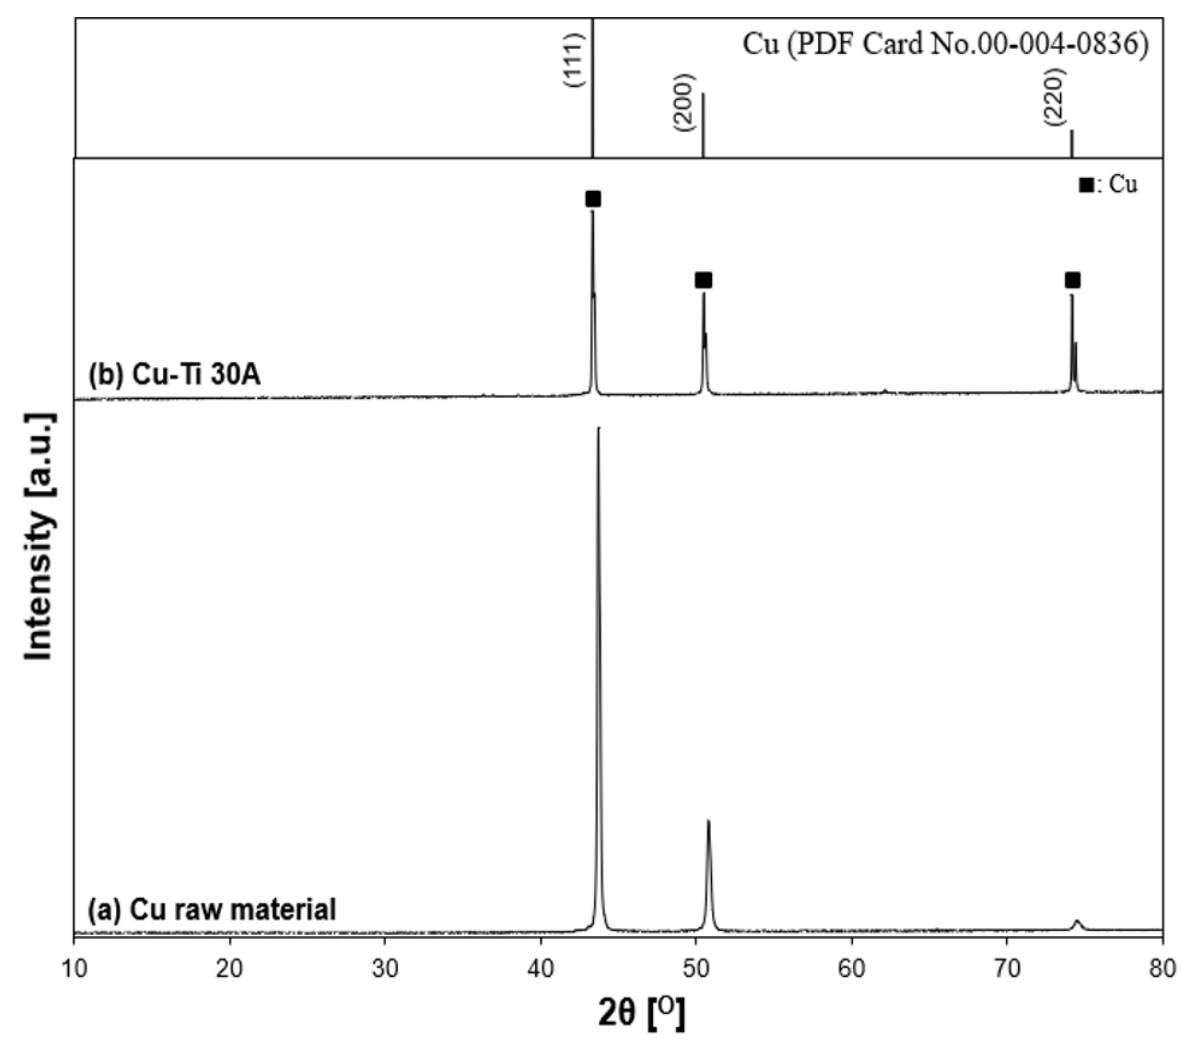
Figure 16. X-ray diffraction patterns of the Cu–Ti sample. ( a ) Cu electrode raw material and ( b ) Cu–Ti 30 A: ( (cid:4) ) Ti ( ■ ) Cu.